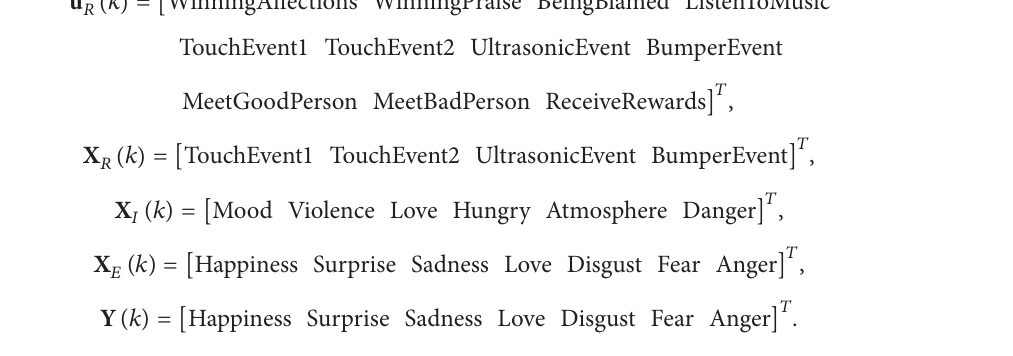
Table 2: The input matrix B 𝐼